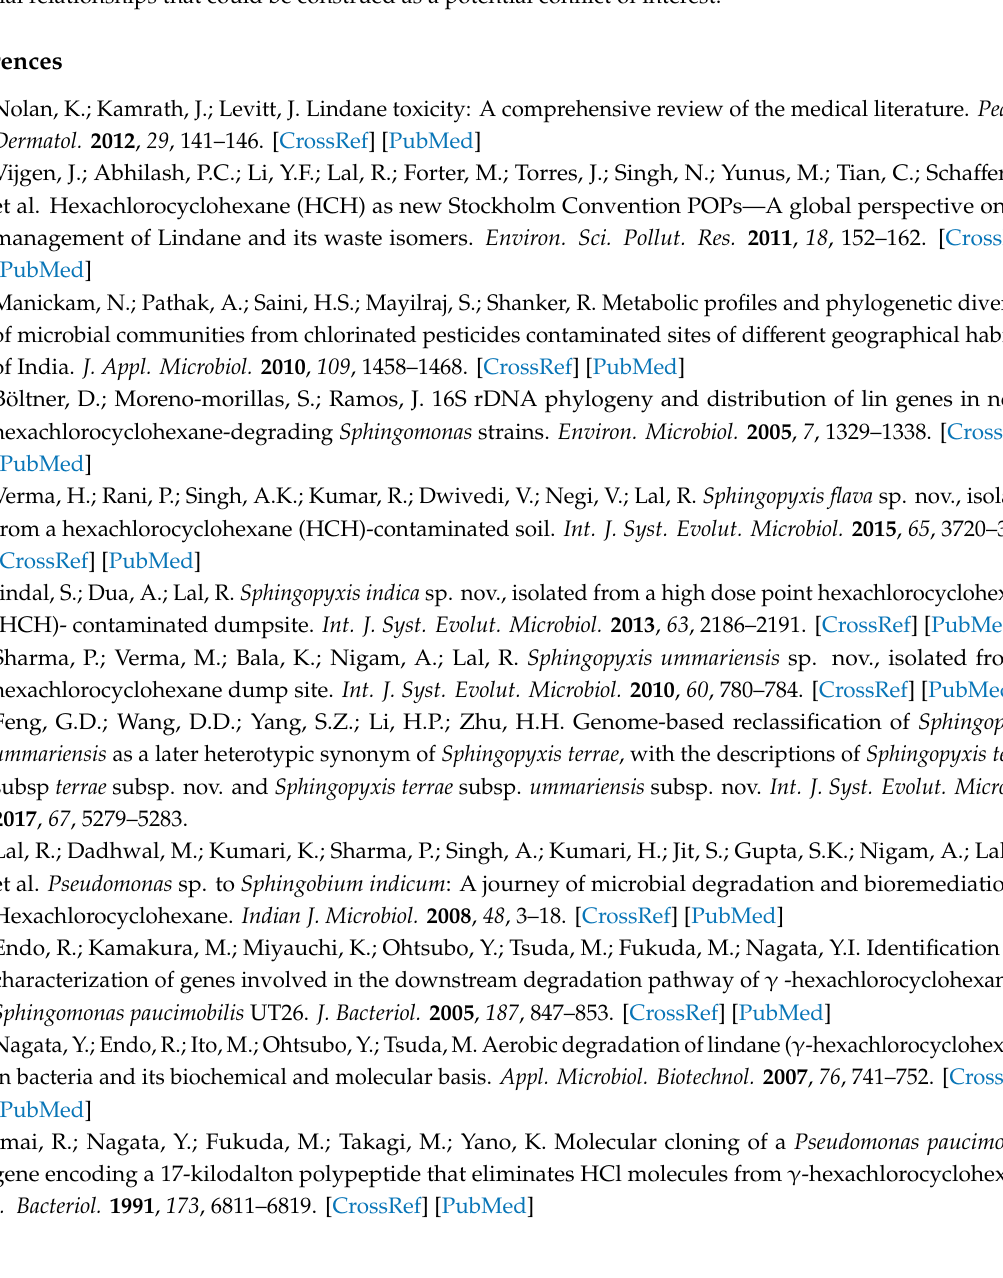
Figure S1: γ -HCH degrading abilities of Sphingopyxis lindanitolerans WS5A3p, Figure S2: Accumulation plots of the Sphingopyxis pangenome , Figure S3: Correlation between minimal phylogenetic distance to the closest neighbour and number of unique protein clusters in the genome, Figure S4: Identification of enzymes potentially involved in aromatic compound degradation, Figure S5: Organization of lin genes (blue) and IS6100 (green) identified on Sphingopyxis lindanitolerans WS5A3p plasmids, Table S1: General statistics of the Sphingopyxis lindanitolerans WS5A3p genome, Table S2: General information about 44 Sphingopyxis genomes used in this work, Table S3: Genome coordinates and locus tags of lin genes identified in WS5A3p genome